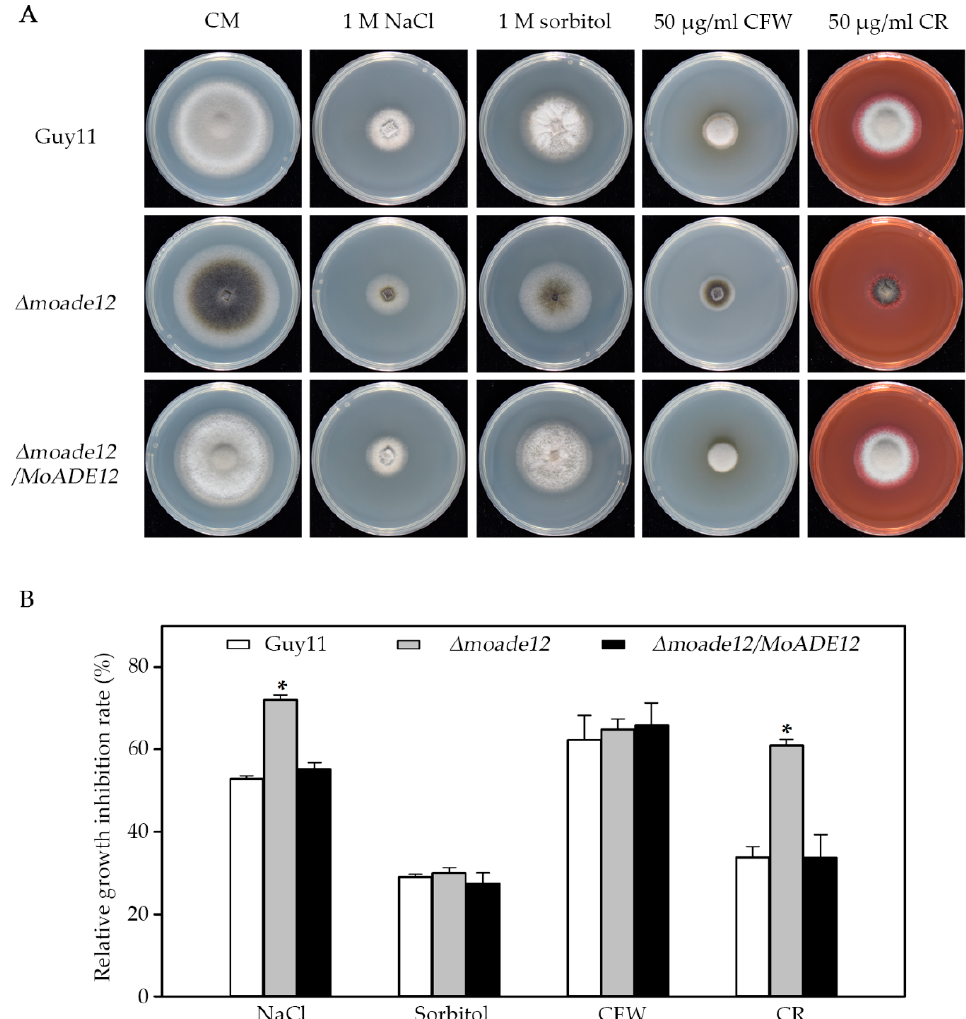
Figure 4. Effect of osmotic pressure and cell wall disruptors on vegetative growth of the indicated M. oryzae strains. ( A ) Vegetative growth of Guy11, Δ moade12 , and Δ moade12/MoADE12 were examined by growth on CM containing NaCl (1 M), sorbitol (1 M), CFW (50 µg/mL), and CR (50 µg/mL) plates at 28 °C for six days. ( B ) Growth inhibition rates of the indicated strains exposed to different chemicals. The experiments were performed in triplicate. ANOVA was performed after arcsine transformation of the growth inhibition rates. However, the original percentages are shown in the figure. Error bars represent the SD. Asterisks in each data column indicate significant differences at p < 0.05.